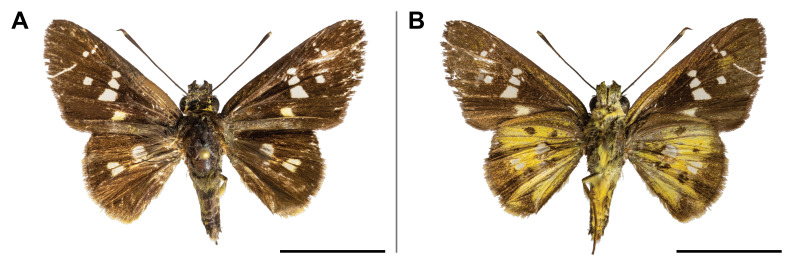
Meza
mabillei (Holland, 1893). A. dorsal view; B. ventral view. The scale bar represents 1 cm.